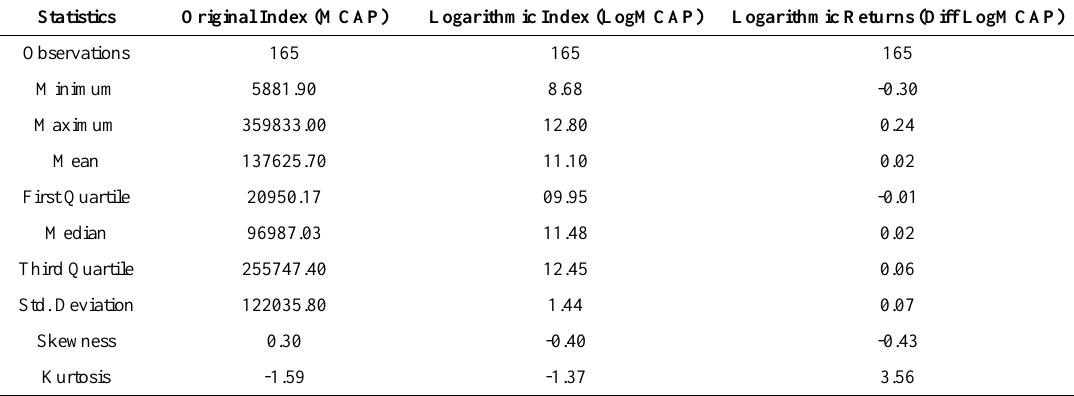
Table A-1. The descriptive statistics of the original, logarithmic, and logarithmic return series